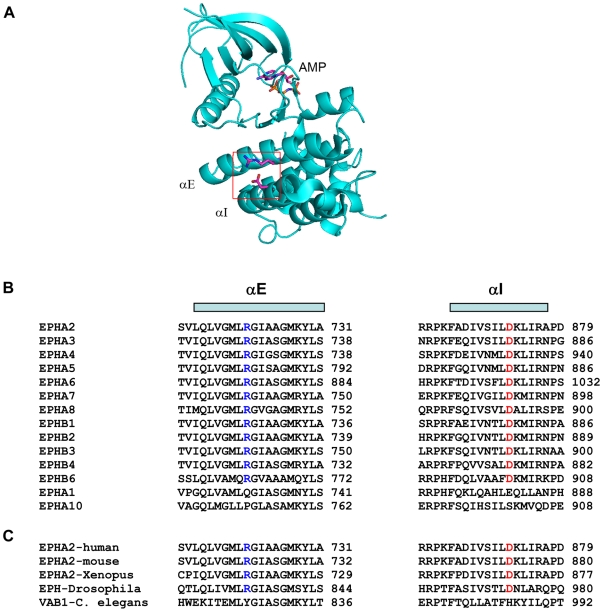
Concordant conservation of Arg721 and Asp872 in EPH kinase domains.(A) Examination of crystal structure of EPHA2 kinase domain reveals that Arg721 in αE forms a salt bridge with Asp872 in αI. (B) Concordant conservation of Arg721 and Asp872 in different members of human Eph kinases. Note that EPHA9 and EPHB5 are not present in human genome and are not shown. (C) The same residues are also concordantly conserved across different species.